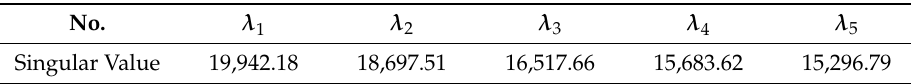
Table 2. Singular values of the trajectory matrix.